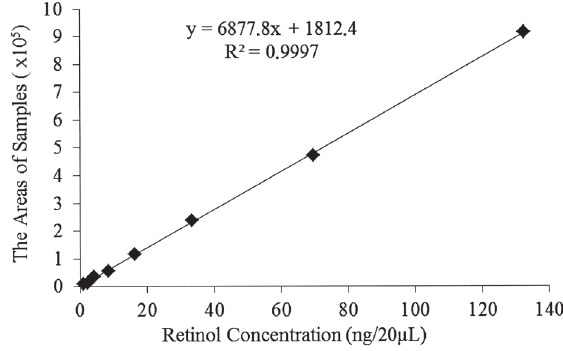
Figure 1 - Calibration curve pattern in different concentrations, demonstrating the equation of the line and linear regression coefficient (R 2 ).